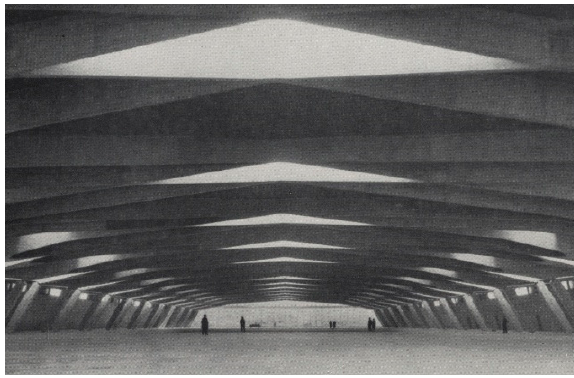
Figure 7. Interior view of Morandi’s Pavilion V.